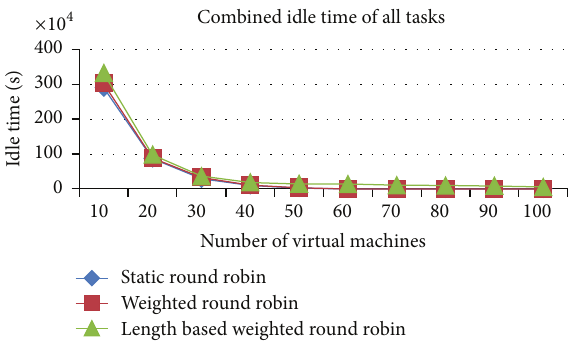
Figure 16: Idle time of all tasks (space shared).